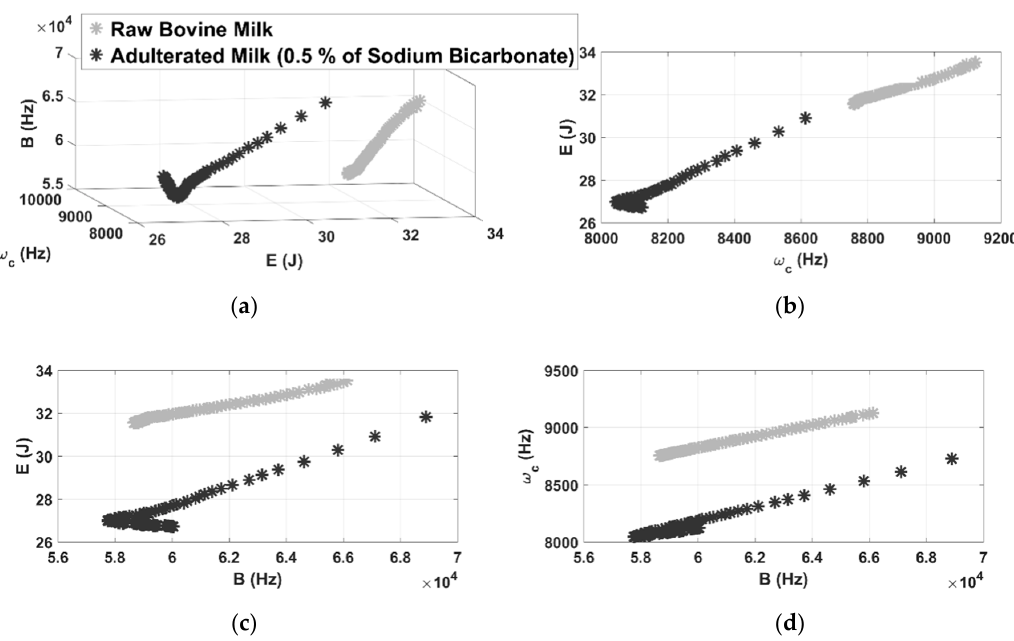
Figure 7. 3D representation of color maps for sodium bicarbonate contamination ( a ) and 2D representation of color maps ( b – d ).